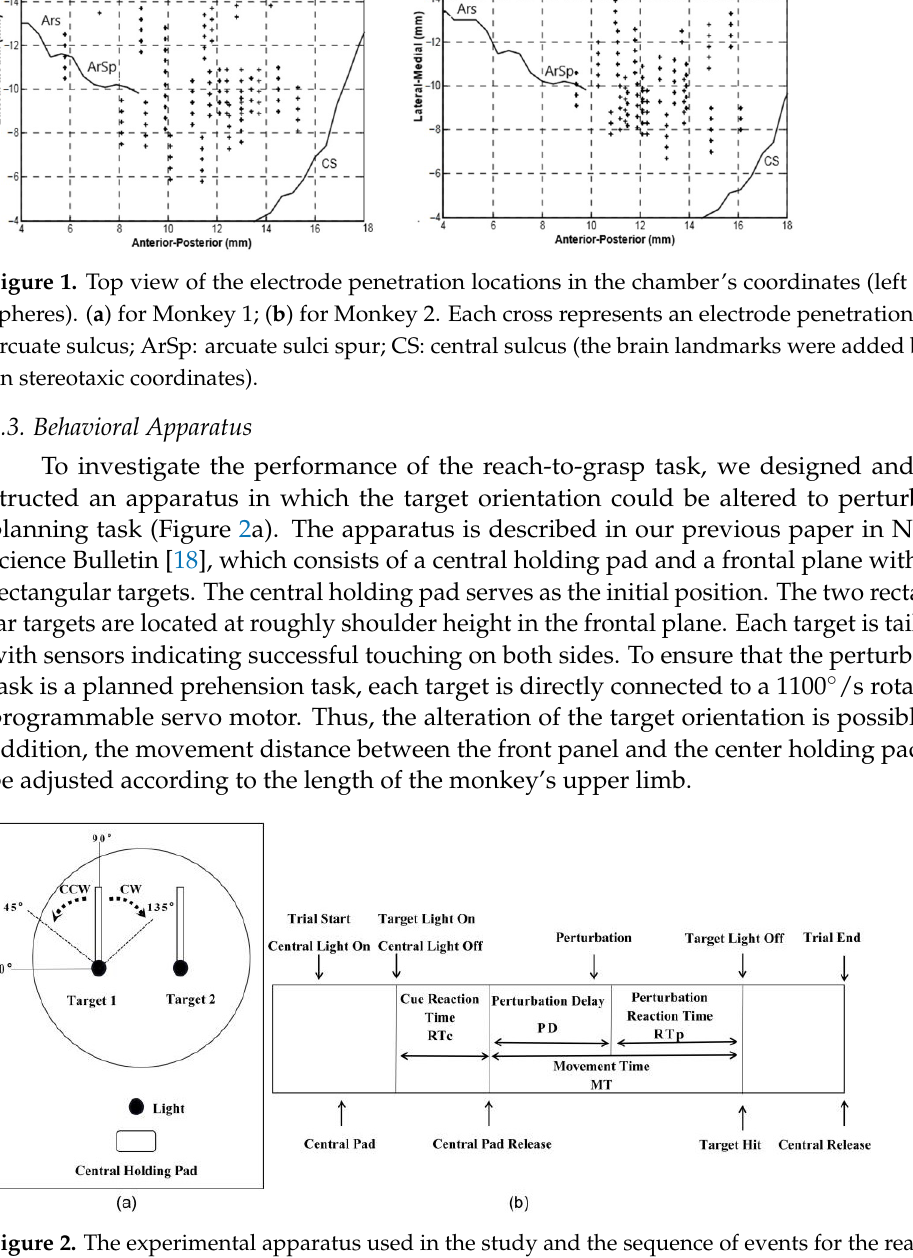
Figure 2. The experimental apparatus used in the study and the sequence of events for the reach-to- grasp task. ( a ) The front view of the experimental apparatus: two targets, central pad, lights, and the target orientation definition. ( b ) The sequence of events for the reach-to-grasp task and the trial epochs. Cue reaction time (RTc), movement time (MT), perturbation delay (PD), and perturbation reaction time (RTp). Cue reaction time is the time from target light coming on to the initiation of reach, indicated by the release of the central holding pad. The movement time is the duration from the release of the holding pad to the grasp of the target. The perturbation delay is the time from the release of the holding pad to perturbation onset. The perturbation reaction time is the time from the perturbation onset to the instant when there was a detectable deviation in the trajectory of the hand orientation to accommodate the new target orientation. The target holding time (THT) was defined as the time from target hit to target release. The center holding time (CHT), was defined as the time from central holding pad hit to target